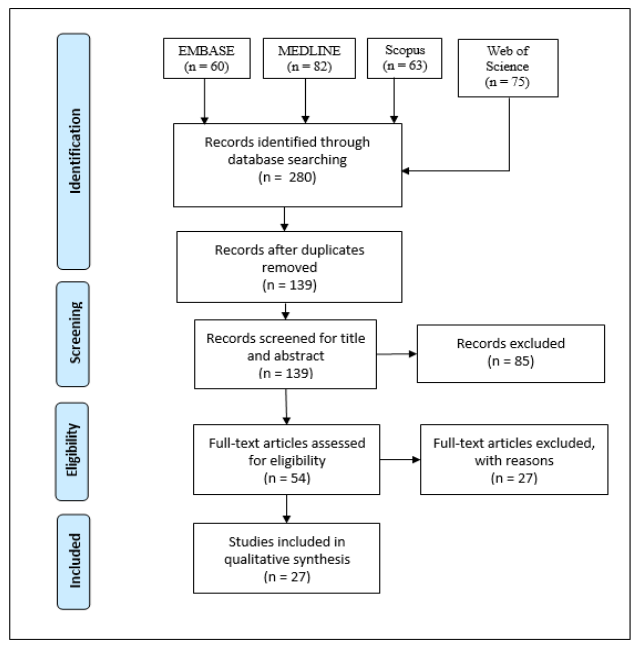
Figure 1. The PRISMA flow diagram.